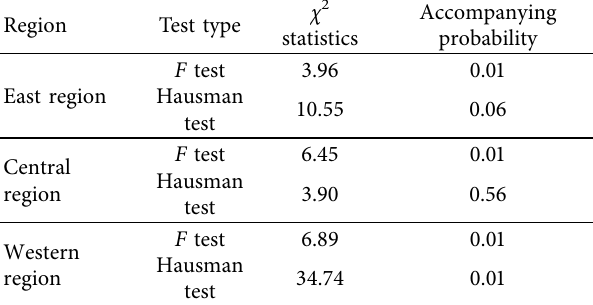
Table 6: Test table for regional model